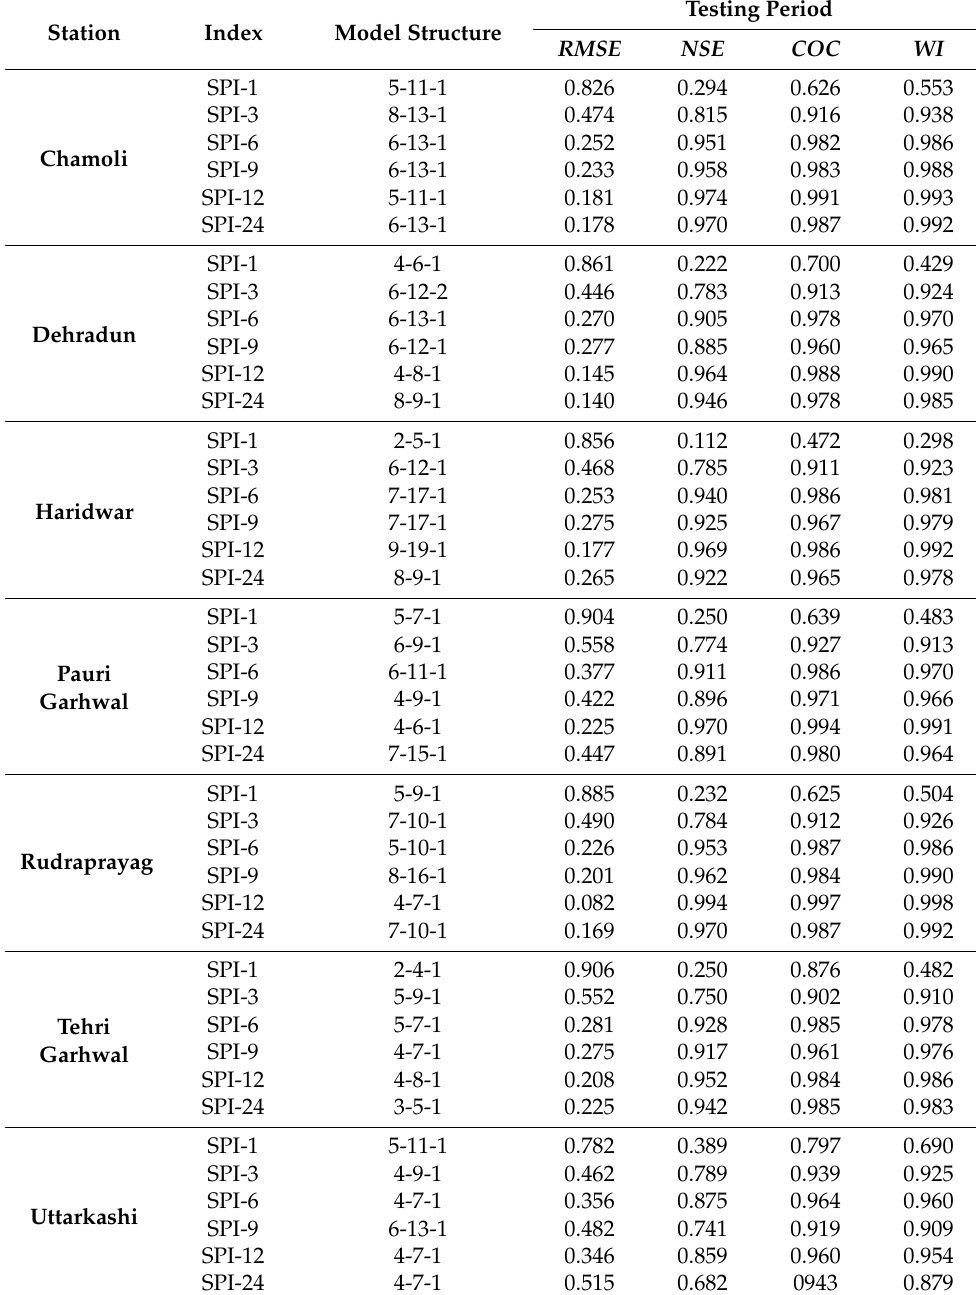
Table 5. Performance of MLPNN model at study